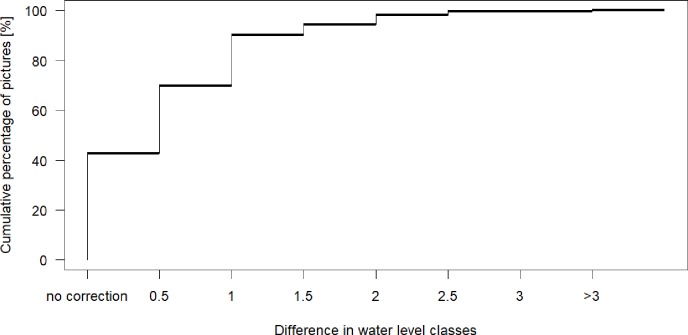
Cumulative frequency distribution of all corrections.Corrections of the original app value based on the mean game votes (between the 10th and 90th percentile). 100% = 841 classified observations.